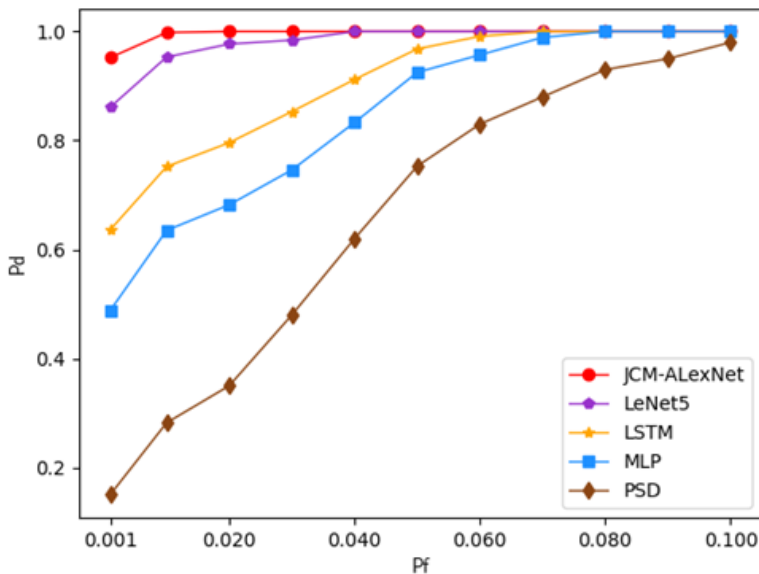
Figure 5. Pd of five algorithms under different Pf when SNR = − 15